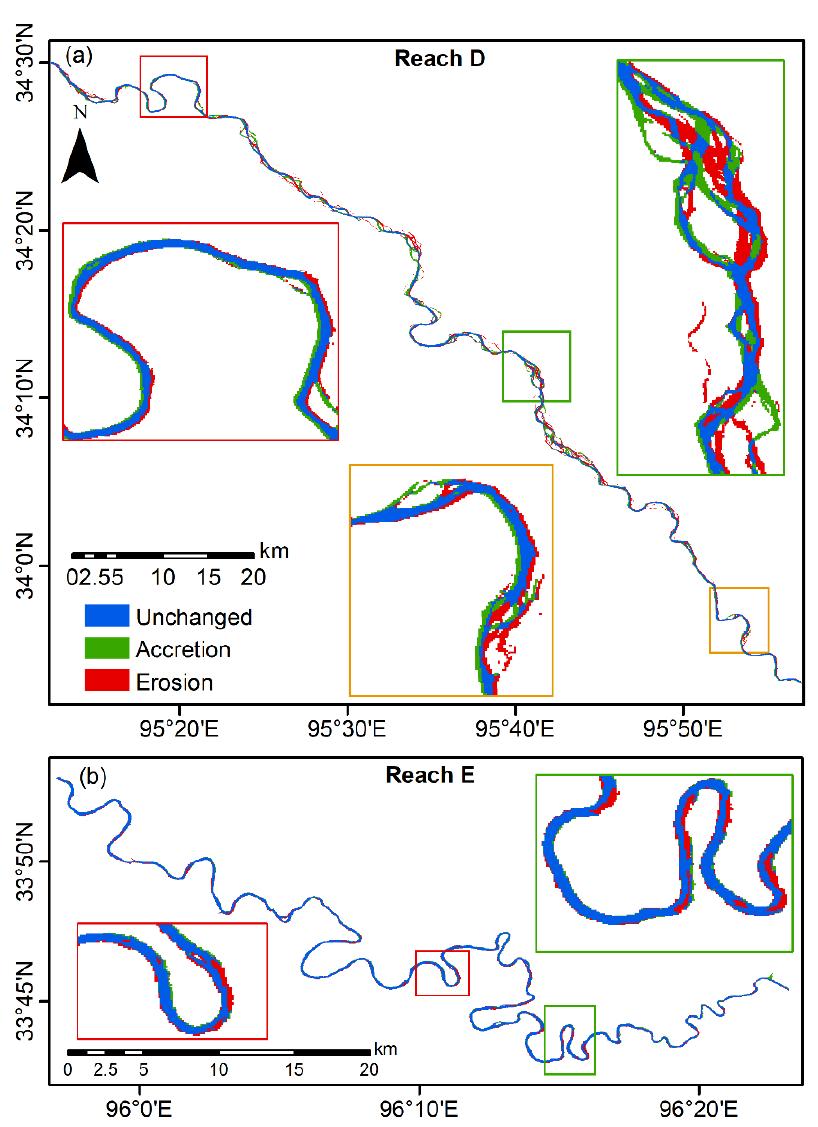
Figure 7. The same as Figure 6, but for the minor braided reach D ( a ) and the main meandering reach E ( b ).